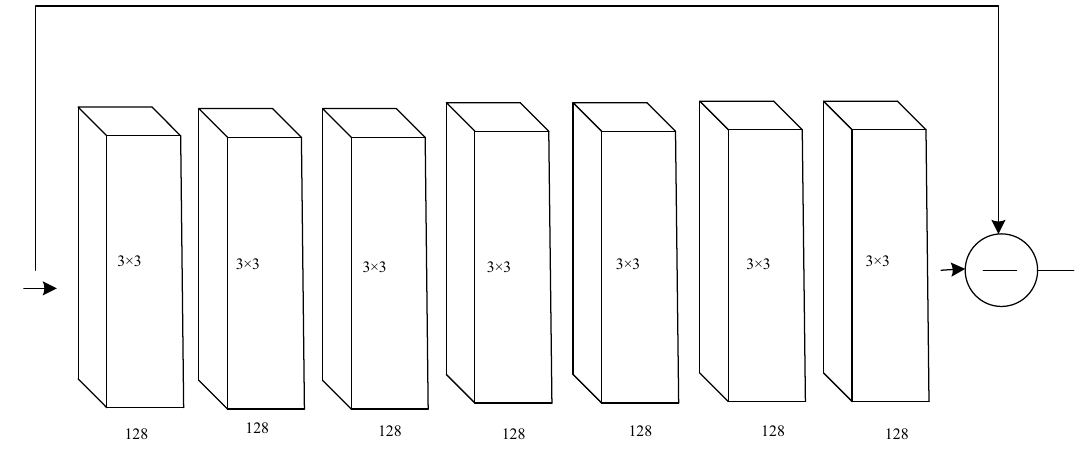
Figure 3: Denoising structure of social network image